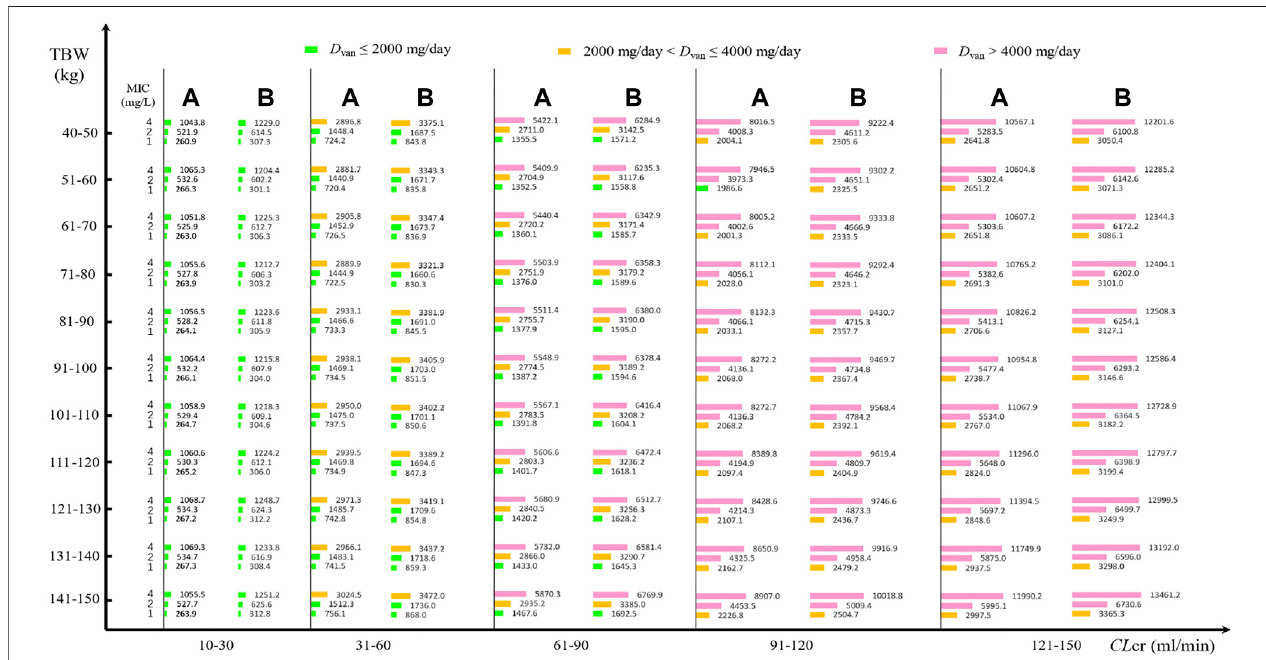
FIGURE2| VANdailydosesforpathogenisolatewithvariousMICsataPTAof90%basedonMCSs( N =5,000). (A) Dailydosedividedevery8 hfordifferentMICs; (B) daily dose divided every 12 h for different MICs.